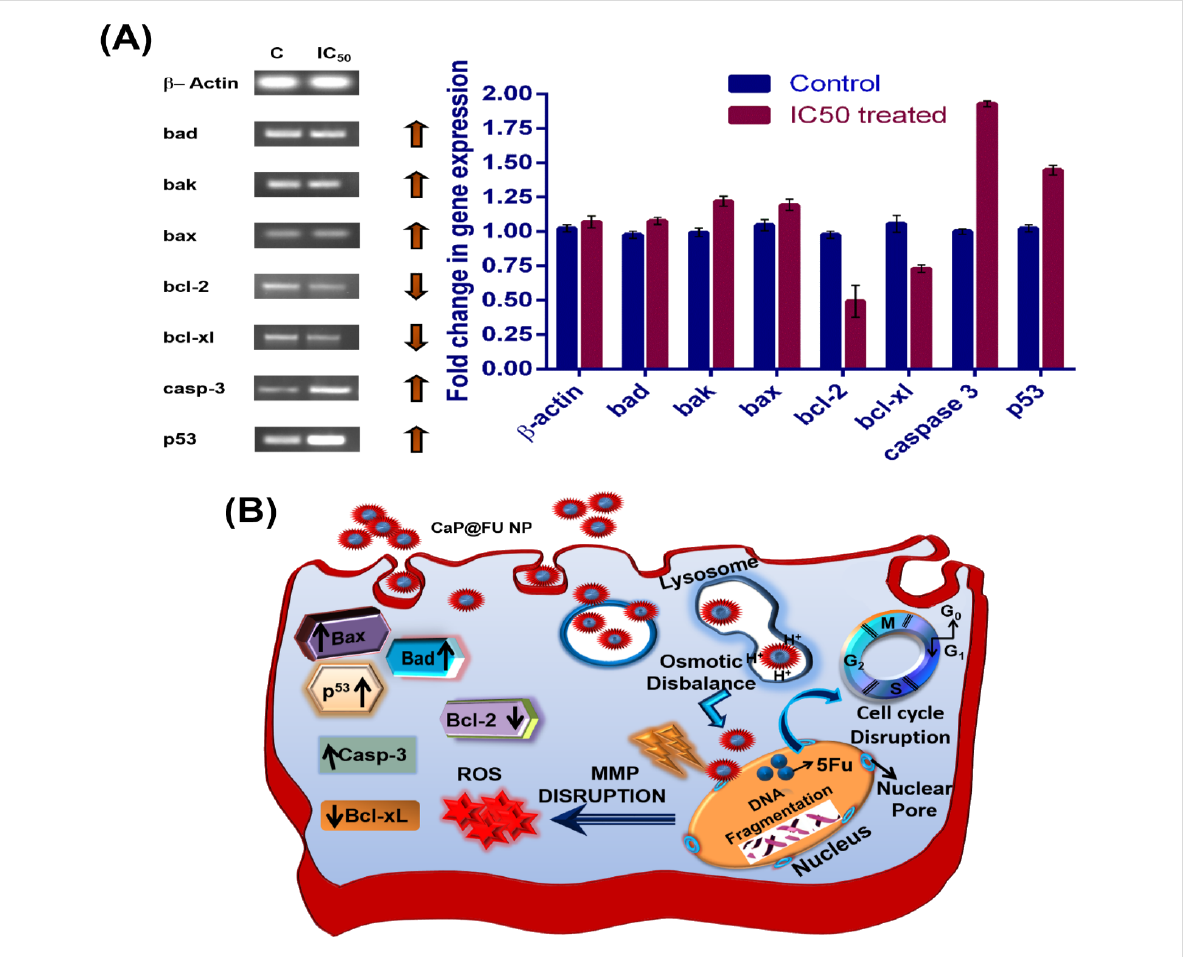
Figure 8: (A) Gene expression studies of proapoptotic and antiapoptotic genes in untreated and CaP@5-FU NP-treated HCT-15 cells using semi- quantitative reverse transcriptase PCR method. (B) Schematic representation of a proposed mechanism for CaP@5-FU-induced apoptosis in cells.